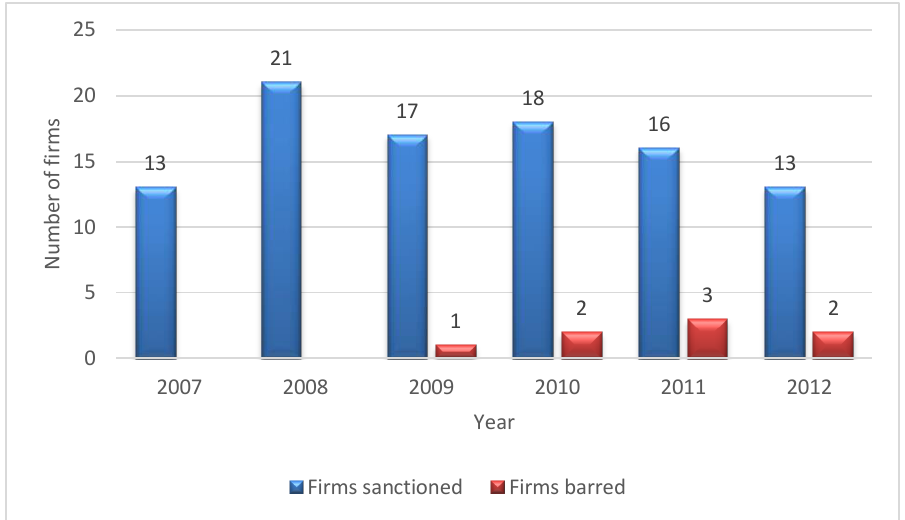
FIGURE 4: Number of firms sanctioned by the CIDB, 2007-2012 Source: CIDB government gazette notices,